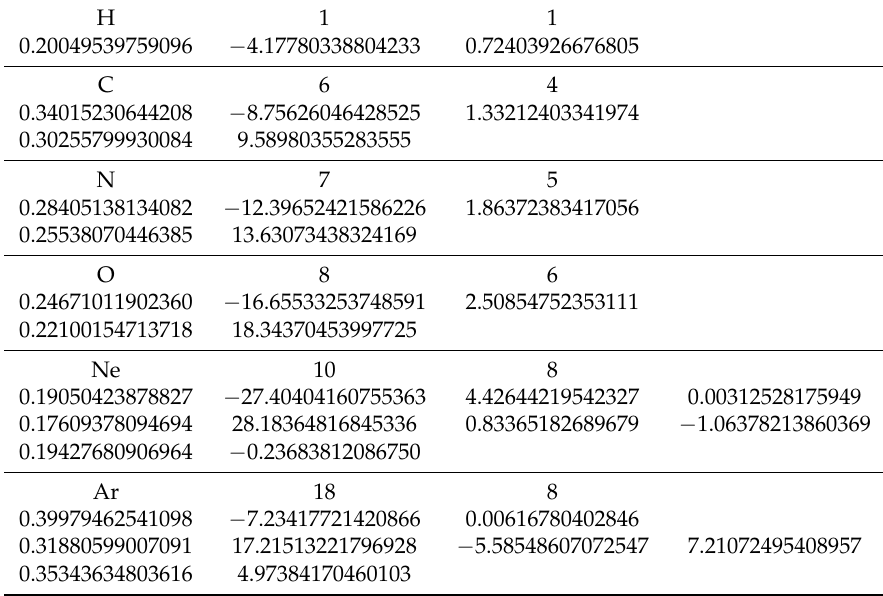
Table A2. PBE0 pseudopotential parameters. The format corresponds to [78]. Pseudopotentials are taken from [79].